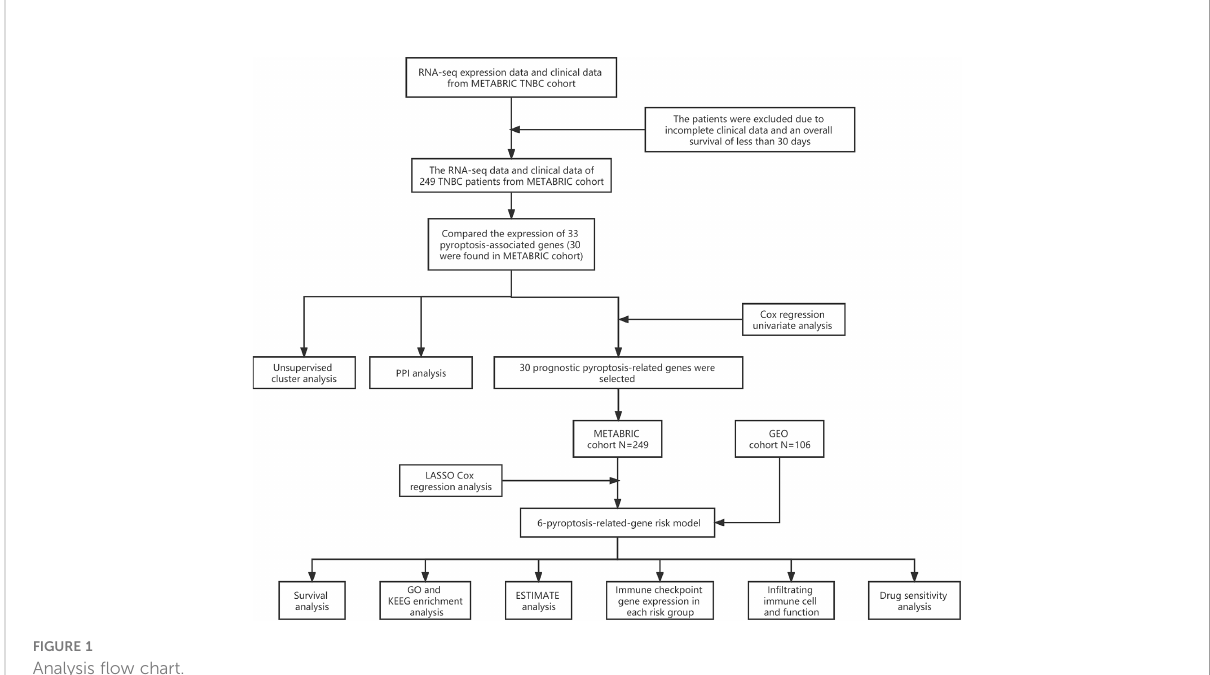
FIGURE 1 Analysis fl ow